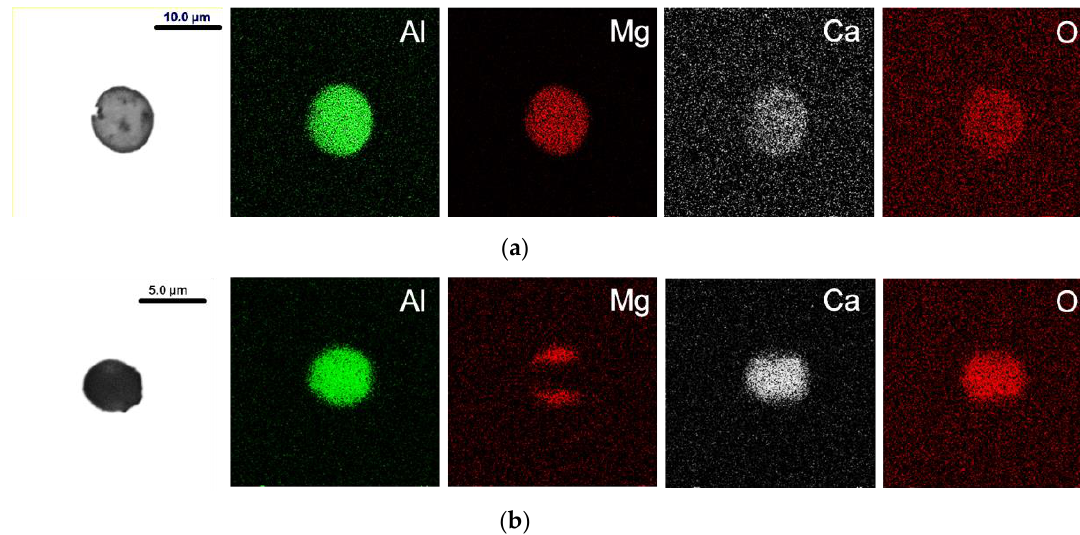
Figure 6. Elemental mapping of typical inclusions in the steel. ( a ) pure phase inclusion, ( b ) multiphase inclusion.